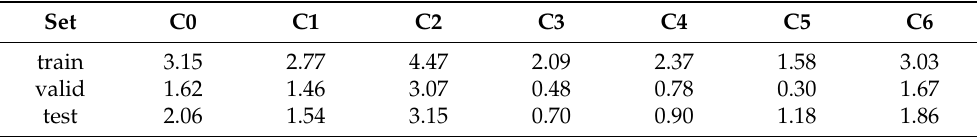
Table 1. Logarithmic class distribution in the training set of the KITTI